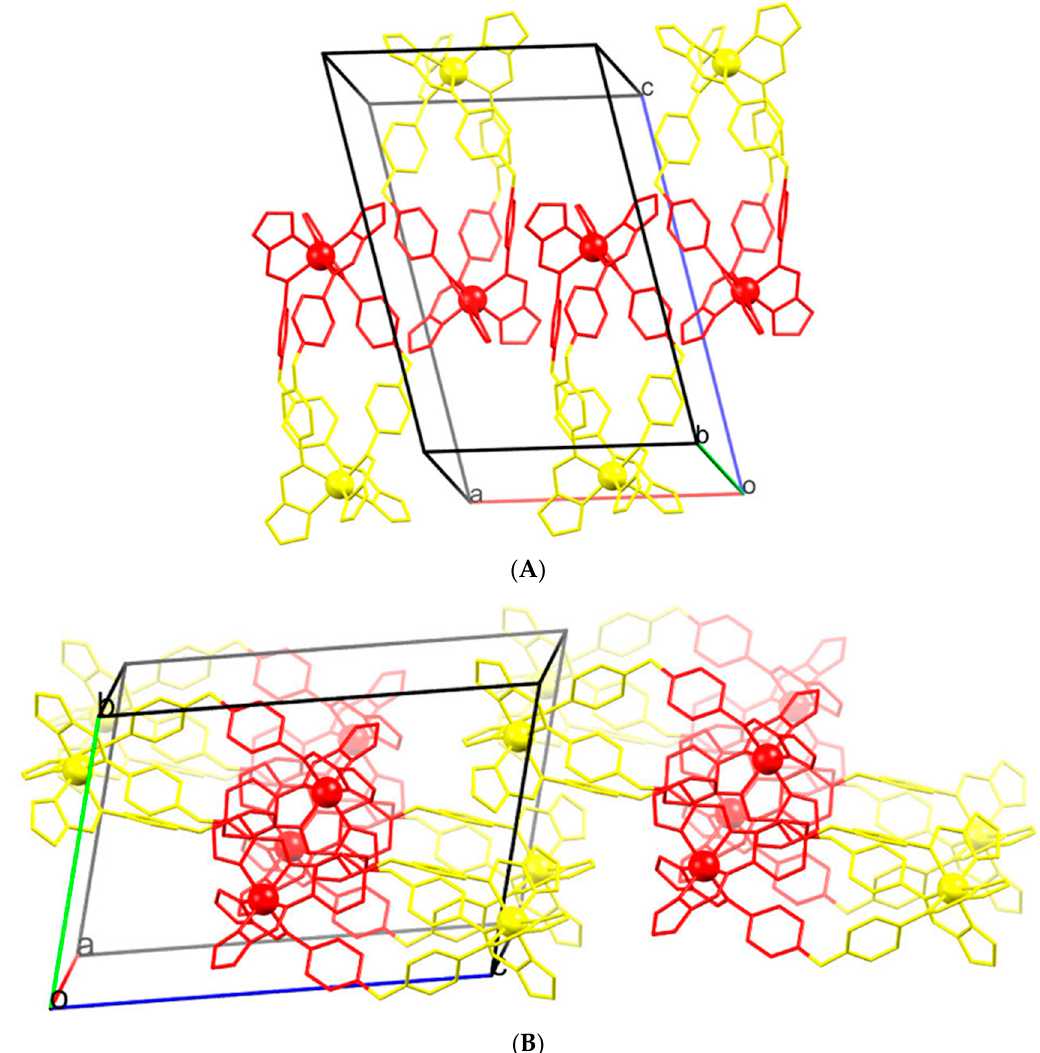
Figure 7. Schematic representations of the crystal packing structure of 3 at 100 K showing the packing of HS (yellow) and mixed spin state (red) Fe(II) centres in undulating rows of metal ions with similar spin states throughout the crystal lattice. Image ( A ) shows the packing in two-dimensions and image ( B ) shows three-dimensional arrangement of Fe(II) centres. Hydrogens, solvent and counter ions have been omitted for clarity.